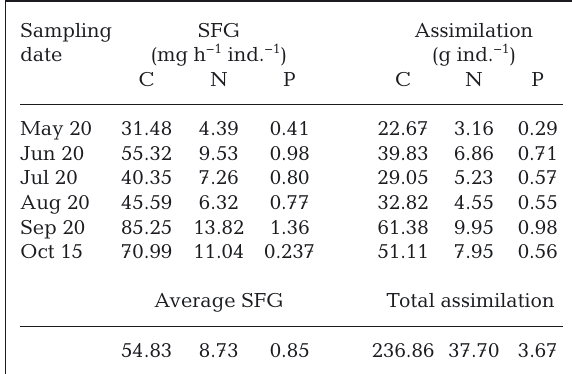
Table 6. Net budget rate (scope for growth [SFG]) and total assimilation of carbon, nitrogen and phosphorus by a silver carp Hypophthalmichthys molitrix individual at monthly intervals during the experimental period in